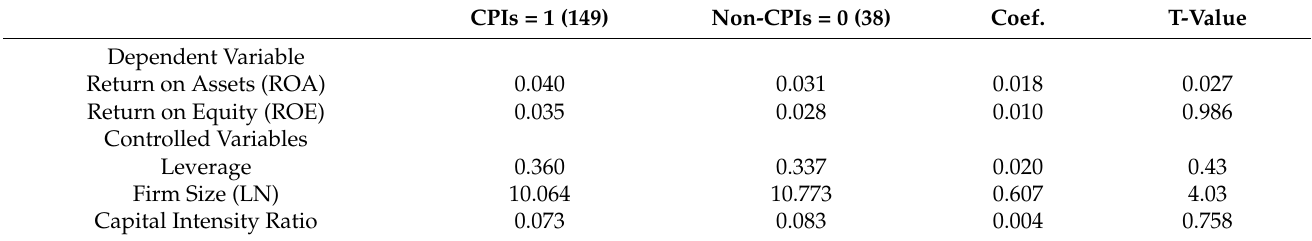
Table 6. Differences between corporate political involvement and non-political involvement 2012 –2017 (N = 1218). CPIs = 1 (149) Non-CPIs = 0 (38) Coef. T-Value